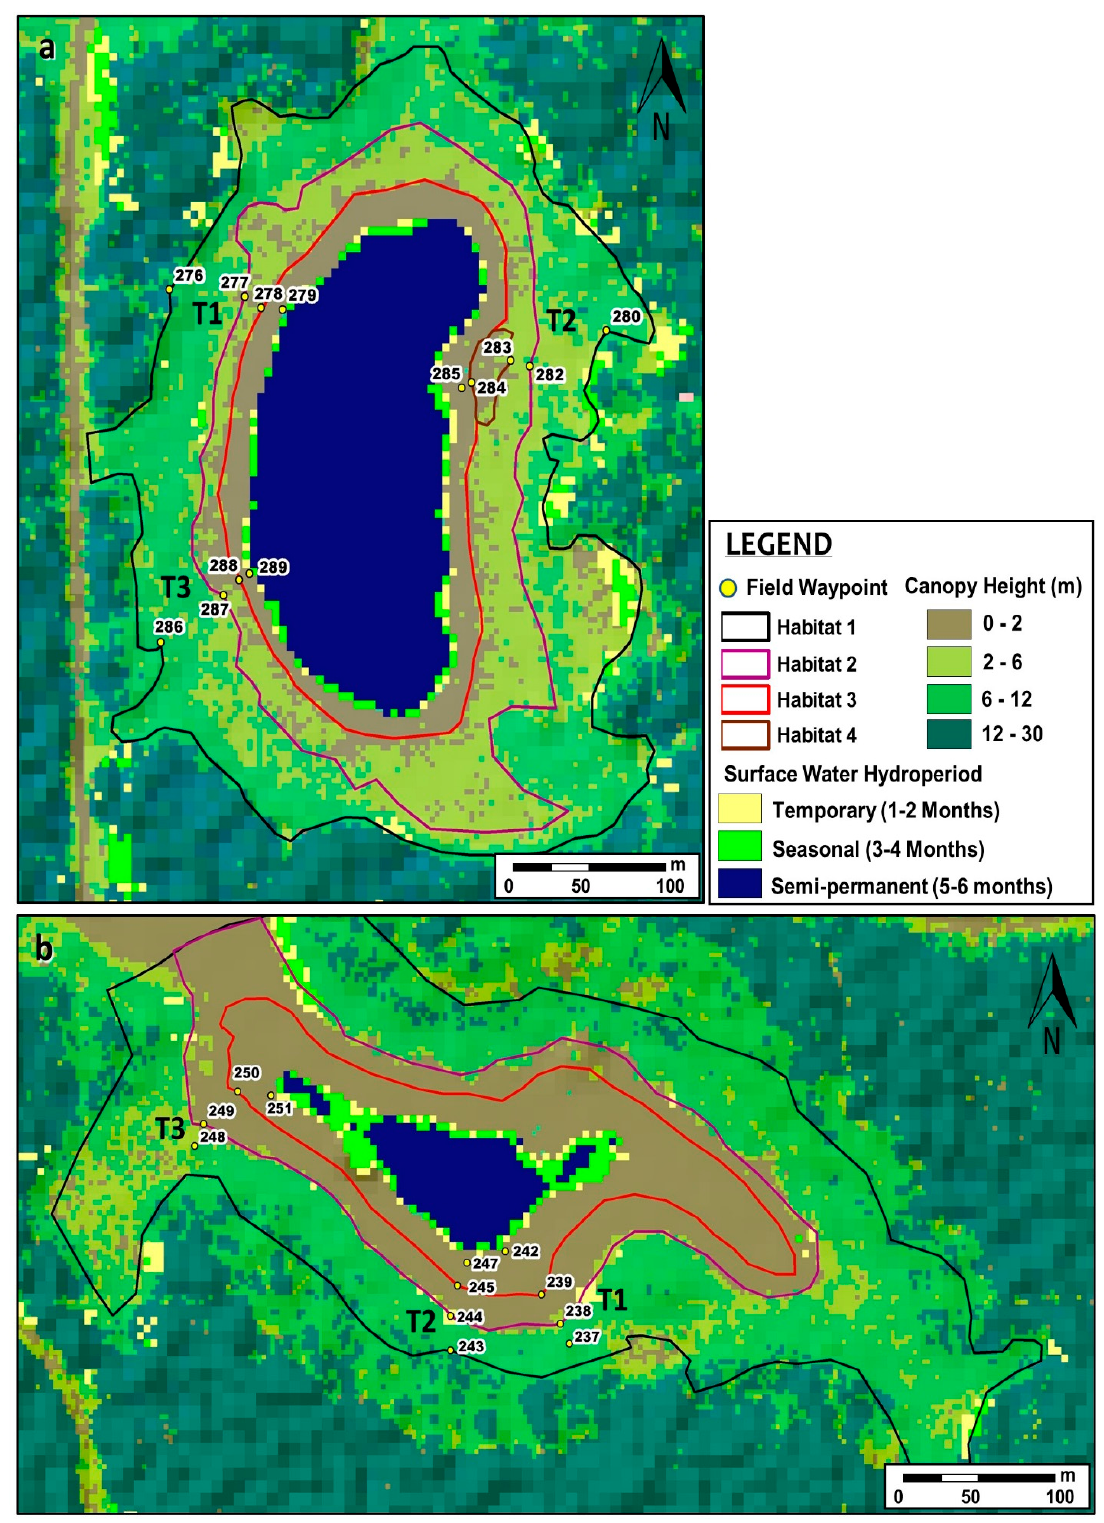
Figure 11. Field validation of surface water extent and riparian boundaries for late July 2015. ( a ) Pond 42, ( b ) Pond 48. Riparian habitats are extrapolated from highly accurate field data points (Topcon Hiper SR global navigation satellite system (GNSS)), a series of SPOT optical imagery, and DEM data, then tested against canopy height cover. Field waypoints represent boundaries observed between riparian